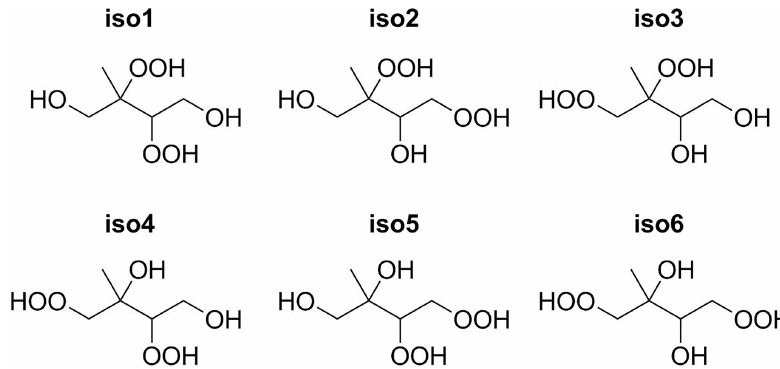
Figure 1. Structural isomers of ISOP ( OOH ) 2 .